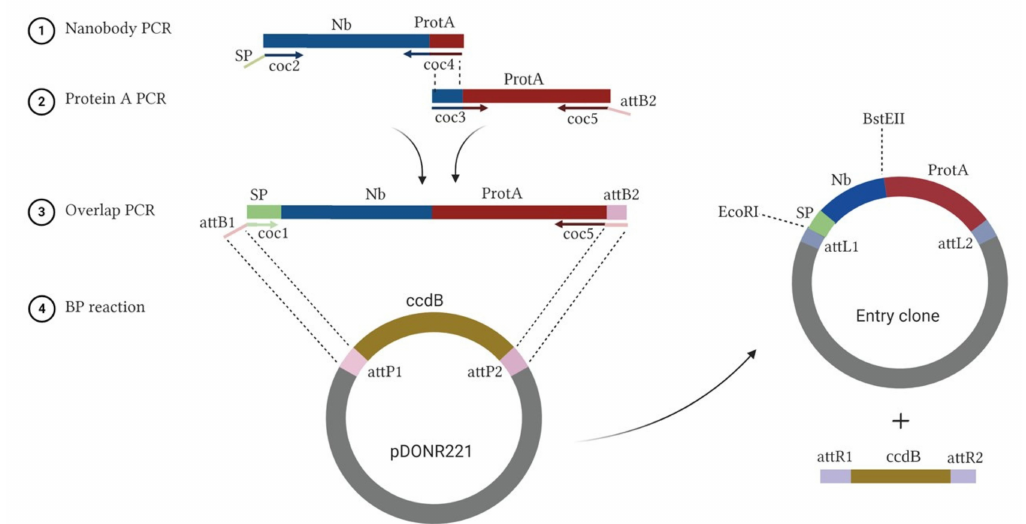
Figure 1. Cloning of Nanobodies (Nb)-protein A (ProtA) fusion gene for surface display in L. lactis . The signal peptide (SP), the Nb genes and the anchor domain of ProtA were amplified in separate PCR reactions and the gene fragments were fused in an overlap PCR reaction introducing the attB sites of the Gateway system at both ends. Created in